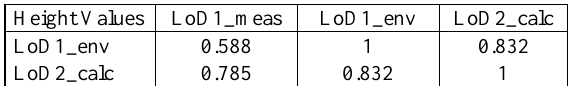
Table 1. Correlation of three different height measures from LoD1 and LoD2 datasets for 4132 buildings within the research area.